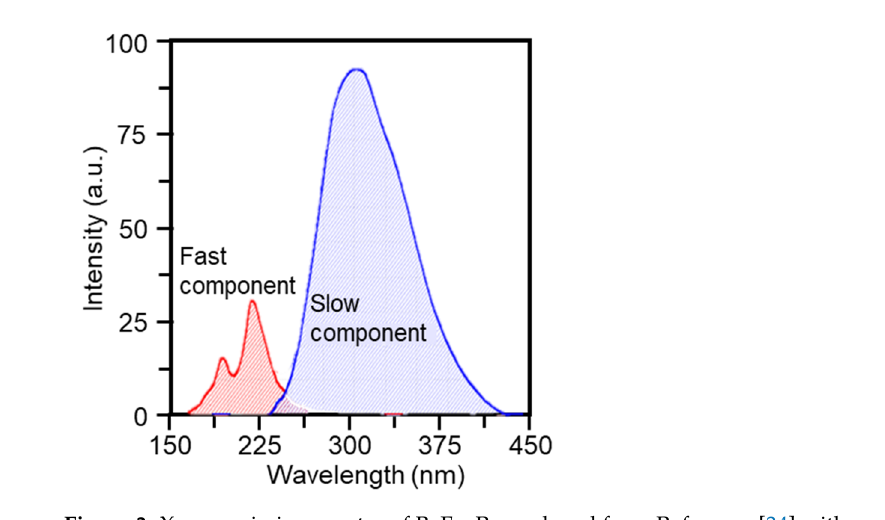
Figure 3. X-ray emission spectra of BaF 2 . Reproduced from Reference [34] with open access.